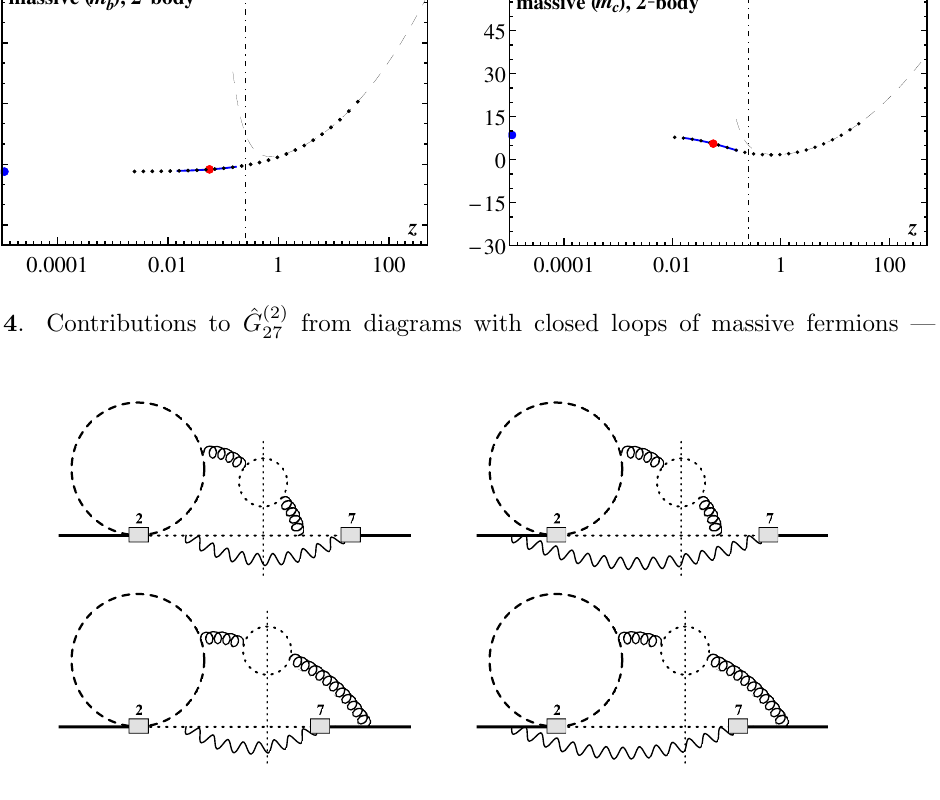
Figure 5 . Diagrams corresponding to the last (lower) plot in (cid:12)gure